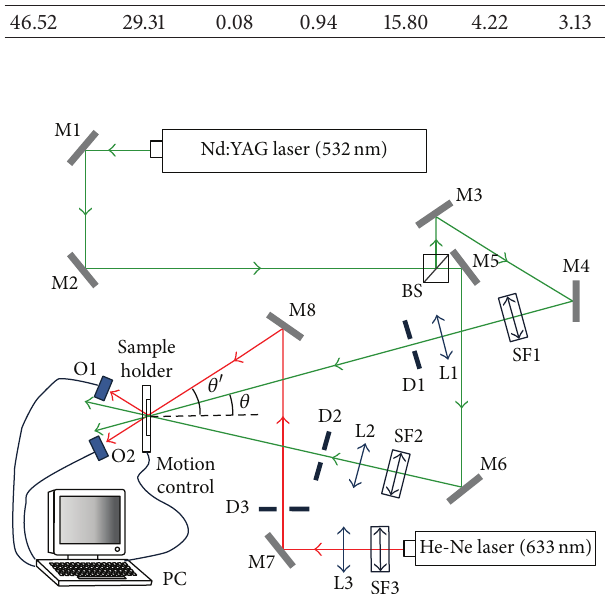
Figure 1: Experimental setup. BS: beam splitter, Mi: mirror, SFi: spatial filter, Li: lens, Di: diaphragm, Oi: optical power meter, and PC: data